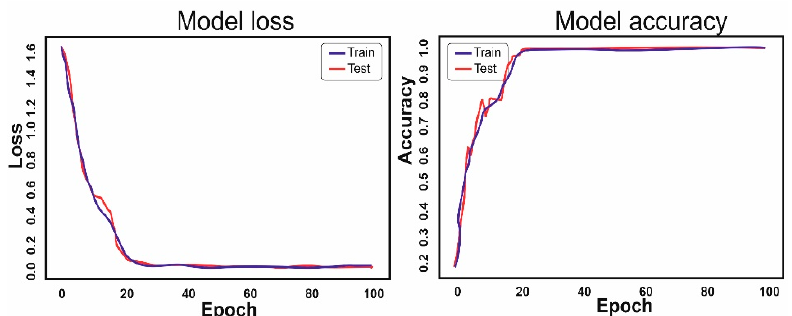
Figure 6. Graphs of the loss function and accuracy of boxers with 1 year of training experience.